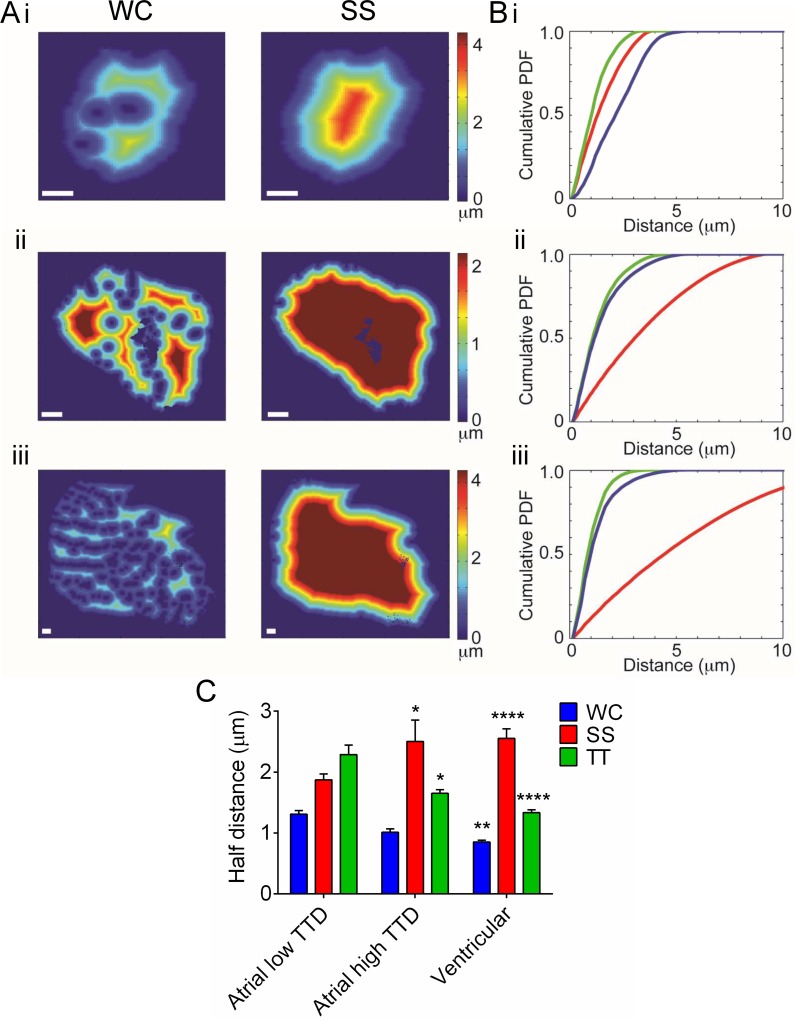
Distance maps in selected atrial and ventricular cells from tissue sections.A) Representative distance maps in (i) atrial cells with ‘low TTD’, (ii) atrial cells with ‘high TTD’ and (iii) ventricular cells. Scale bar represents 12 μm. Calibration bar shows distance to nearest membrane. B) Representative cumulative histograms for each cell type (blue–all membrane, red–surface membrane only, green–t-tubule membrane only). C) Mean half-distance to nearest membrane. * P<0.05, ** P<0.01, *** P<0.001 one-way ANOVA with Bonferroni post-test. Atrial cells with ‘low TTD’ n = 17, atrial cells with ‘high TTD’ n = 5, ventricular cells n = 24.